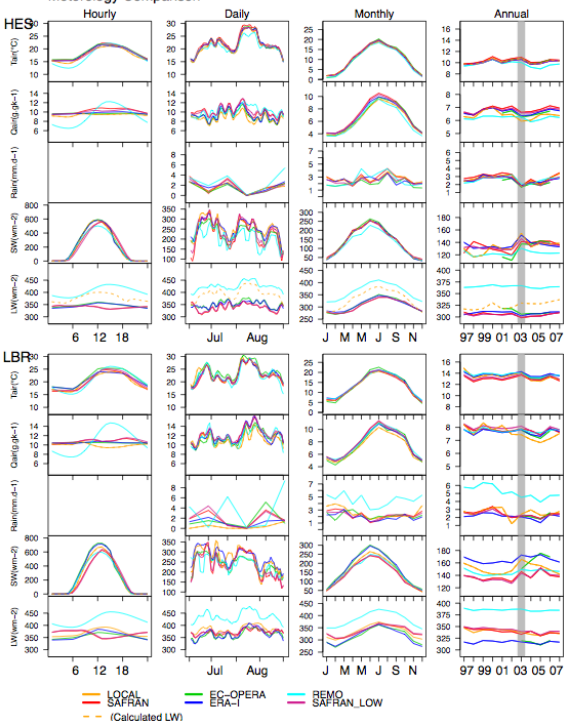
Fig. B1. Figure B1 155 156